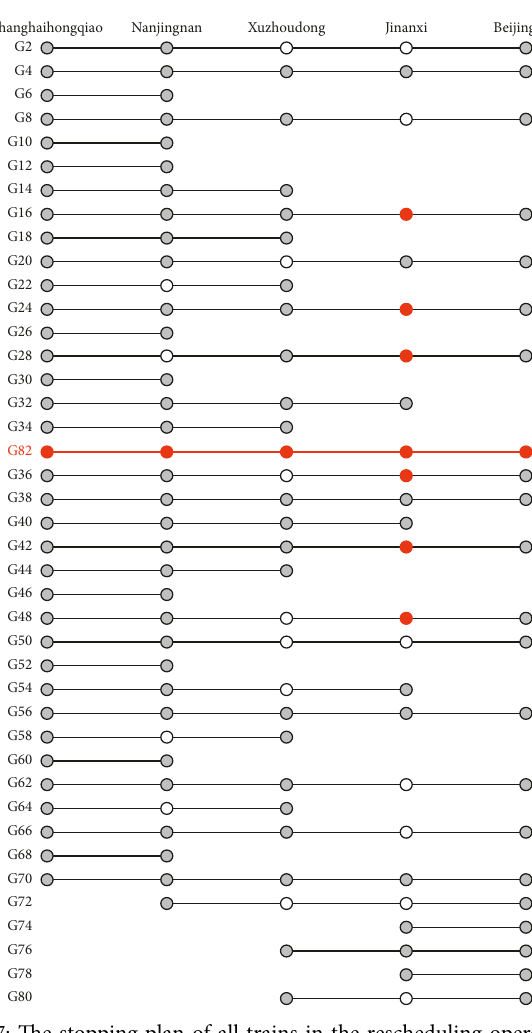
Figure 7: The stopping plan of all trains in the rescheduling operation plan. Table 4: The variation of observed value with different boundary values α